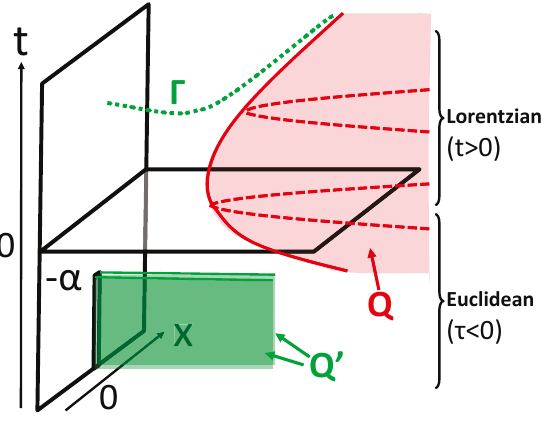
Figure 21 . The spacetime geometry of gravity dual of the joining local quench. The red region de(cid:12)ned by z > G L ( x; t ) should be removed. The boundary of this region, which we call the red surface, corresponds to the boundary surface Q . Though the green surface Q 0 is also boundary surface, it should be identi(cid:12)ed with the red